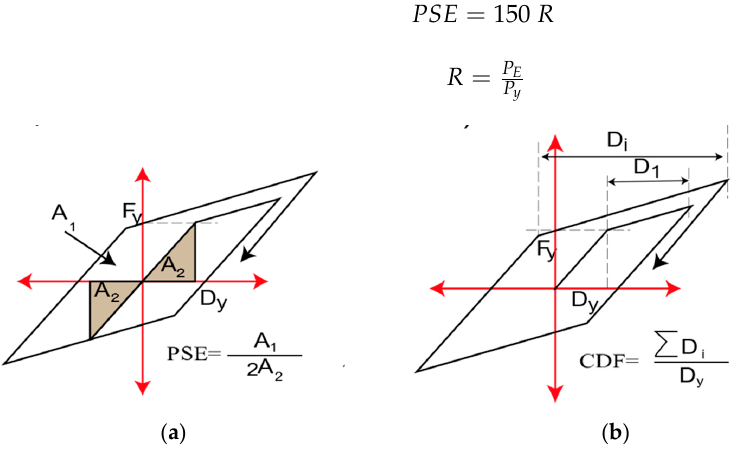
Figure 15 . ( a ) Plastic strain energy (PSE); ( b ) cumulative ductility factor